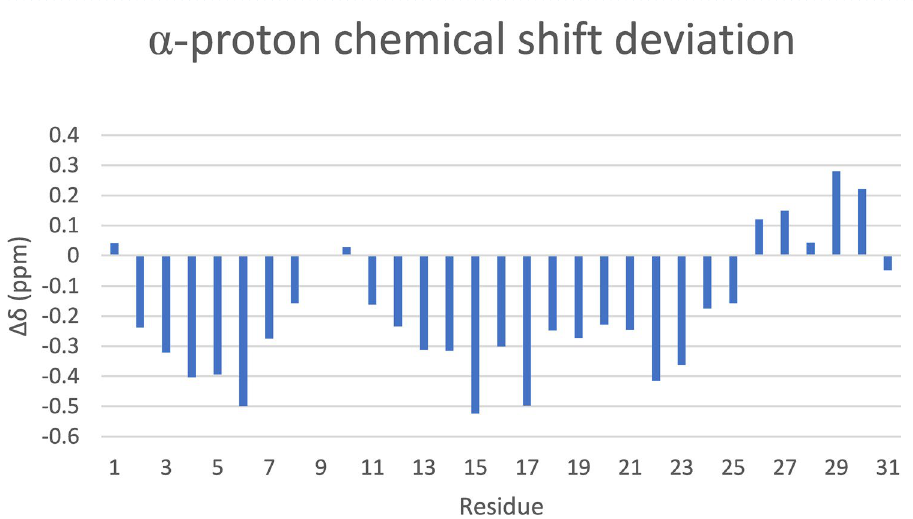
Figure 4. α -proton chemical shift deviation plot of palustrin-Ca in 50% TFE- d 3 -H 2 O. The observed α -proton chemical shifts were compared to the standard random coil chemical shifts ( �δ = δ obs − δ rc